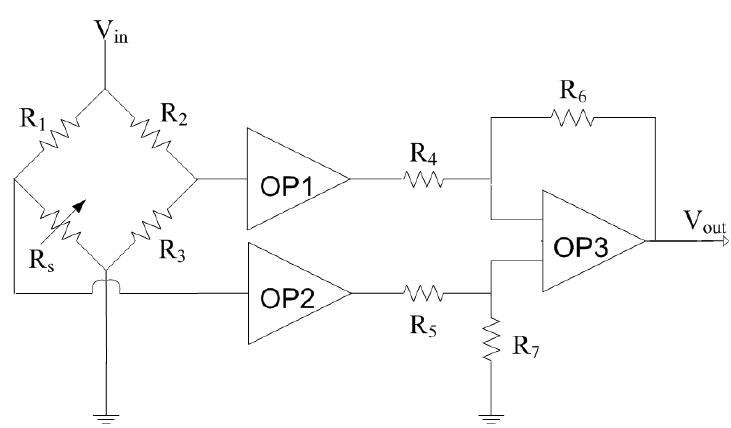
Figure 1. Readout circuit for the ammonia sensor.